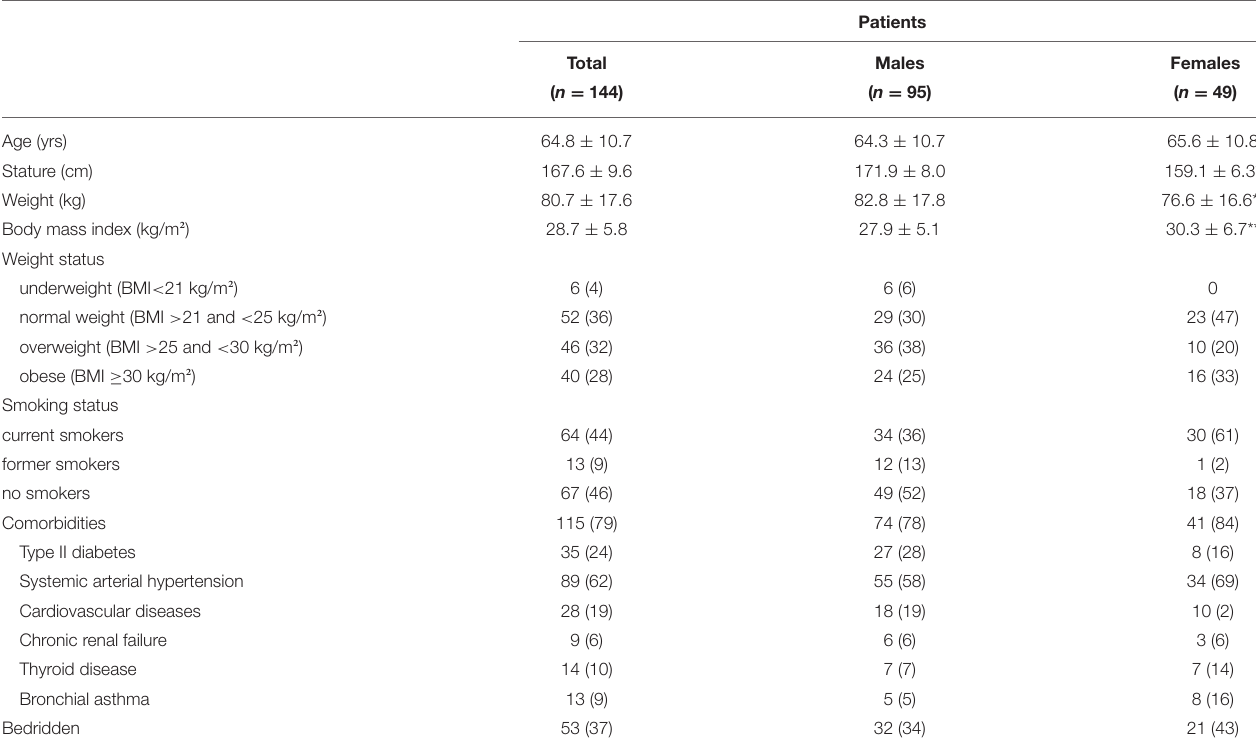
TABLE 1 | Demographic and clinical characteristics of the study population.